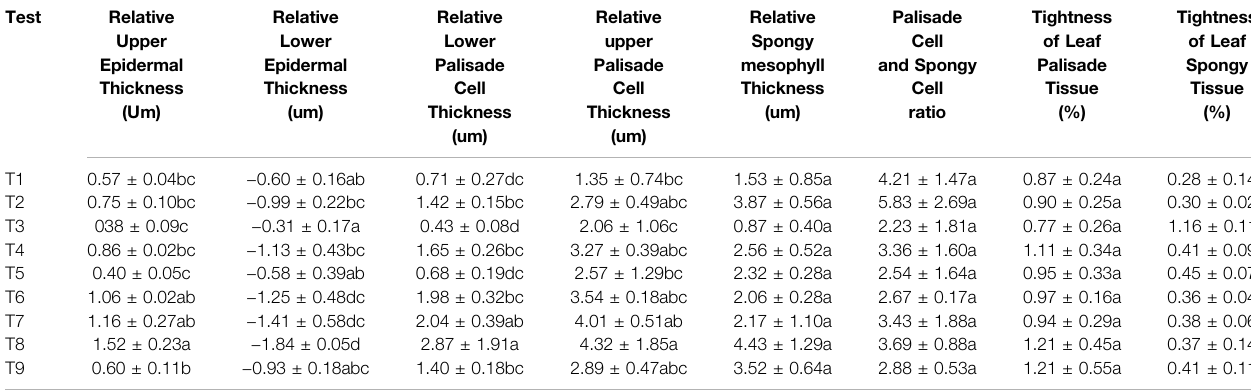
TABLE 4 | Analysis of variability in the growth of anatomical structural indicators of Elaeagnus angustifolia leaves under different regulation methods. Test Relative